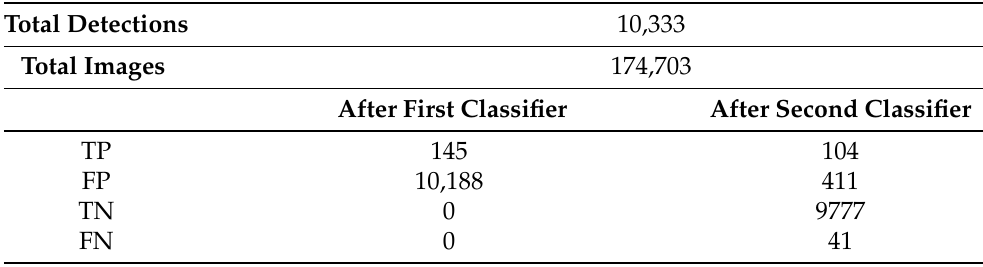
Table 4. Overall metrics of the 29 daily datasets